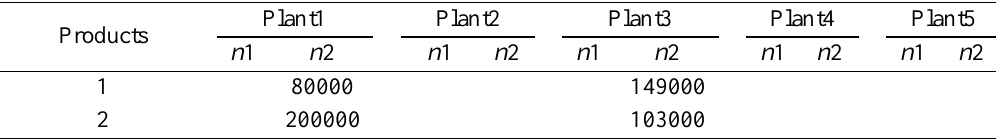
Table 7. Production quantity in planning